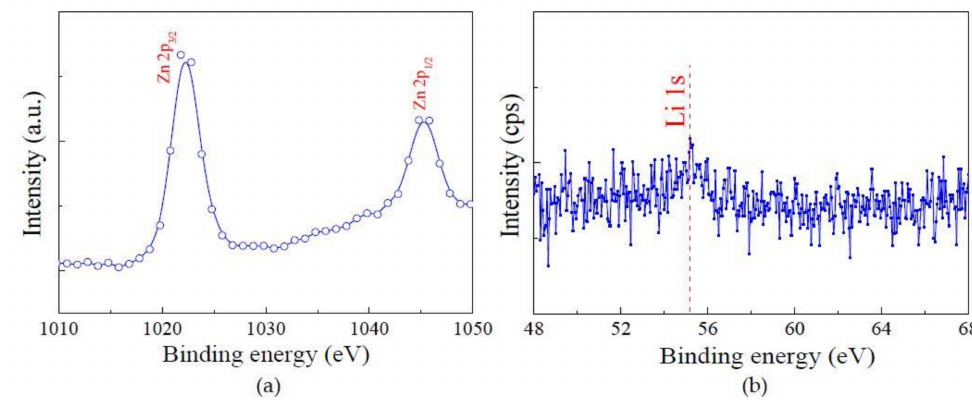
Figure 6. X-ray photoelectron spectroscopy (XPS) spectra of 5 wt% Li-doped ZnO thin films ( a ) XPS spectra for Zn 2p; ( b ) narrow scan at Li 1s peak.